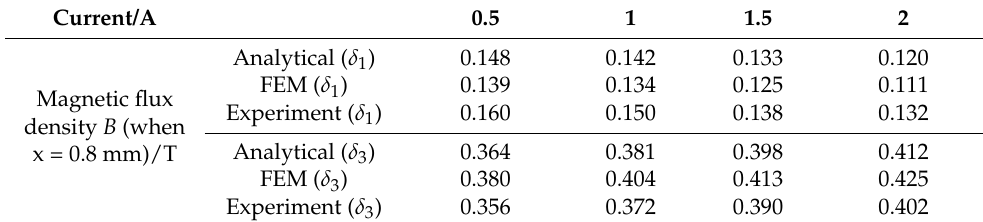
Figure 18. Magnetic flux density curve. ( a ) 0.5 A. ( b ) 1 A. ( c ) 1.5 A. ( d ) 2 A. Table 8. Summary of the magnetic flux density of δ 1 and δ 3 (x = 0.8